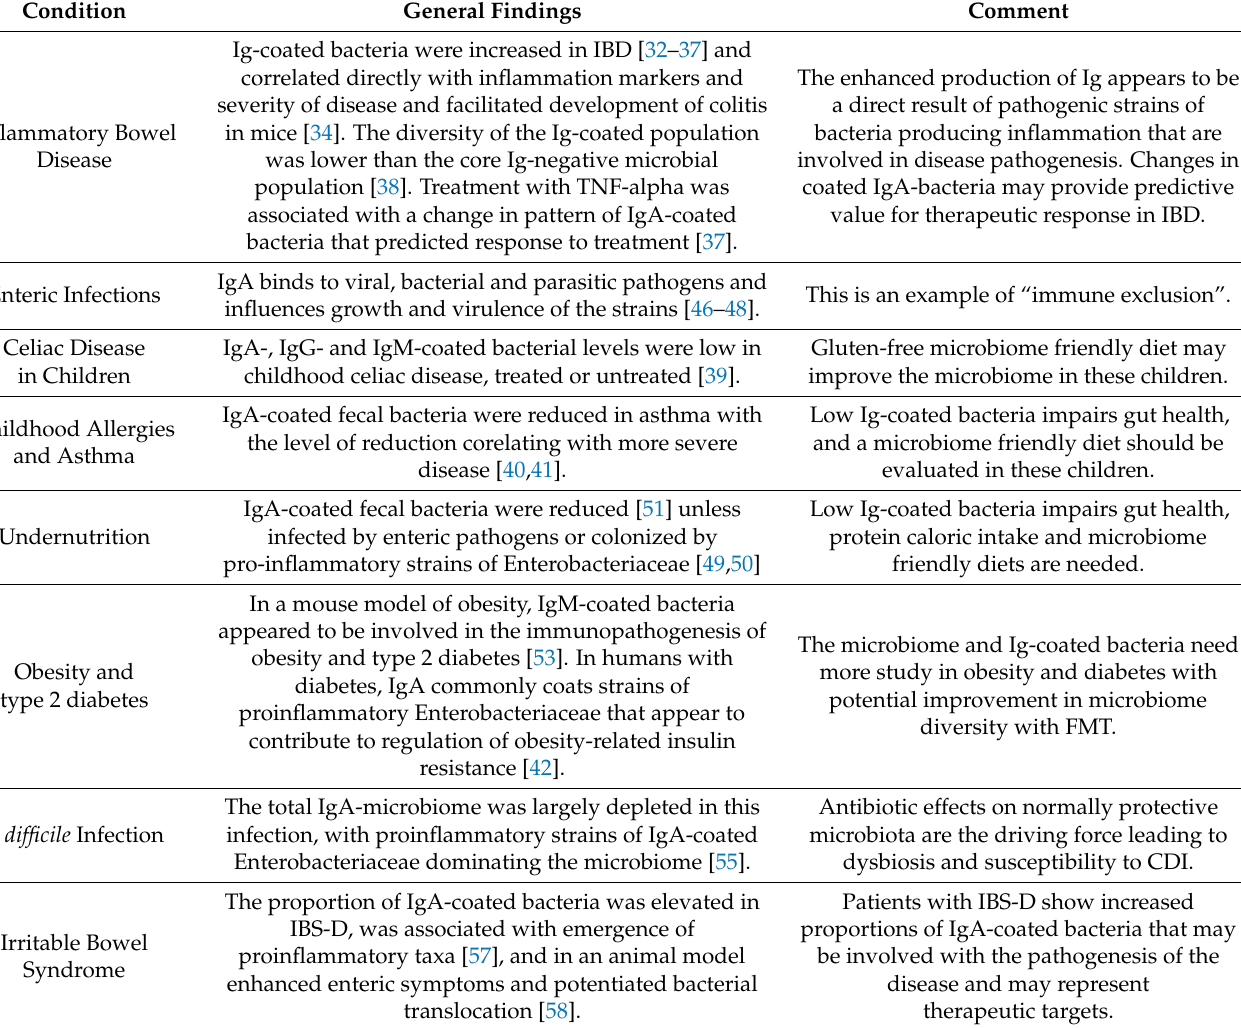
Table 2. IgA-Coated Bacteria in Conditions Associated with Dysbiosis Which Represent Target Con- ditions for Microbial Restoration Through Fecal Microbiota Transplantation, Summary of